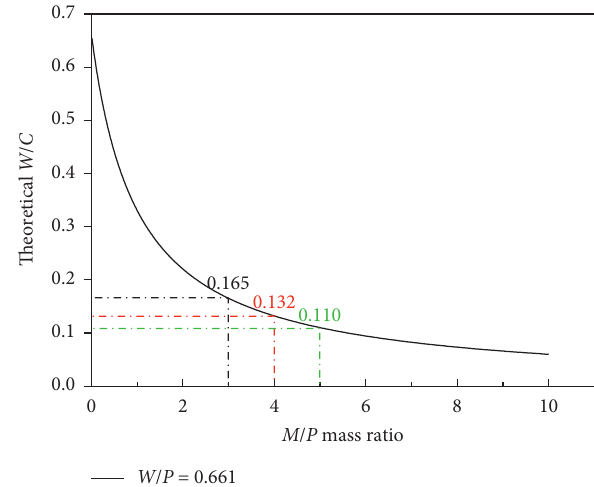
Figure 3: Relationship between the M / P mass ratio and the the- oretical W/C